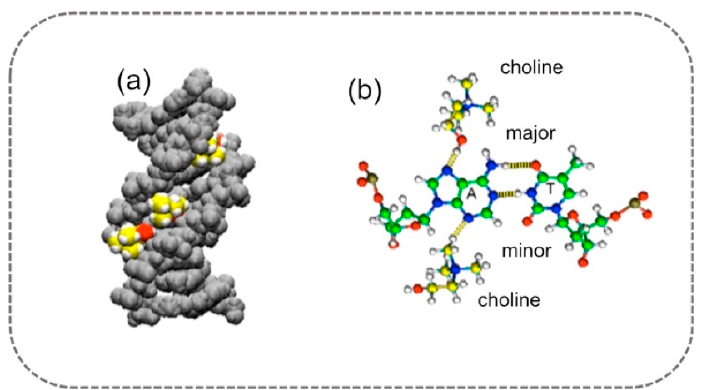
Figure 6. Molecular dynamics simulation of ( a ) choline ions solvating the minor groove of A–T base pairs of duplex DNA; carbon atoms of choline ions are represented in yellow, oxygen atoms of choline ions are represented in red, and hydrogen atoms are in white. ( b ) Atomic-scale representation of the DNA–choline bonds. Adapted with permission from Nakano, M.; Tateishi-Karimata, H.; Tanaka, S.; Sugimoto, N. Choline Ion Interactions with DNA Atoms Explain Unique Stabilization of A–T Base Pairs in DNA Duplexes: A Microscopic View. J. Phys. Chem. B 2014 , 118 ,